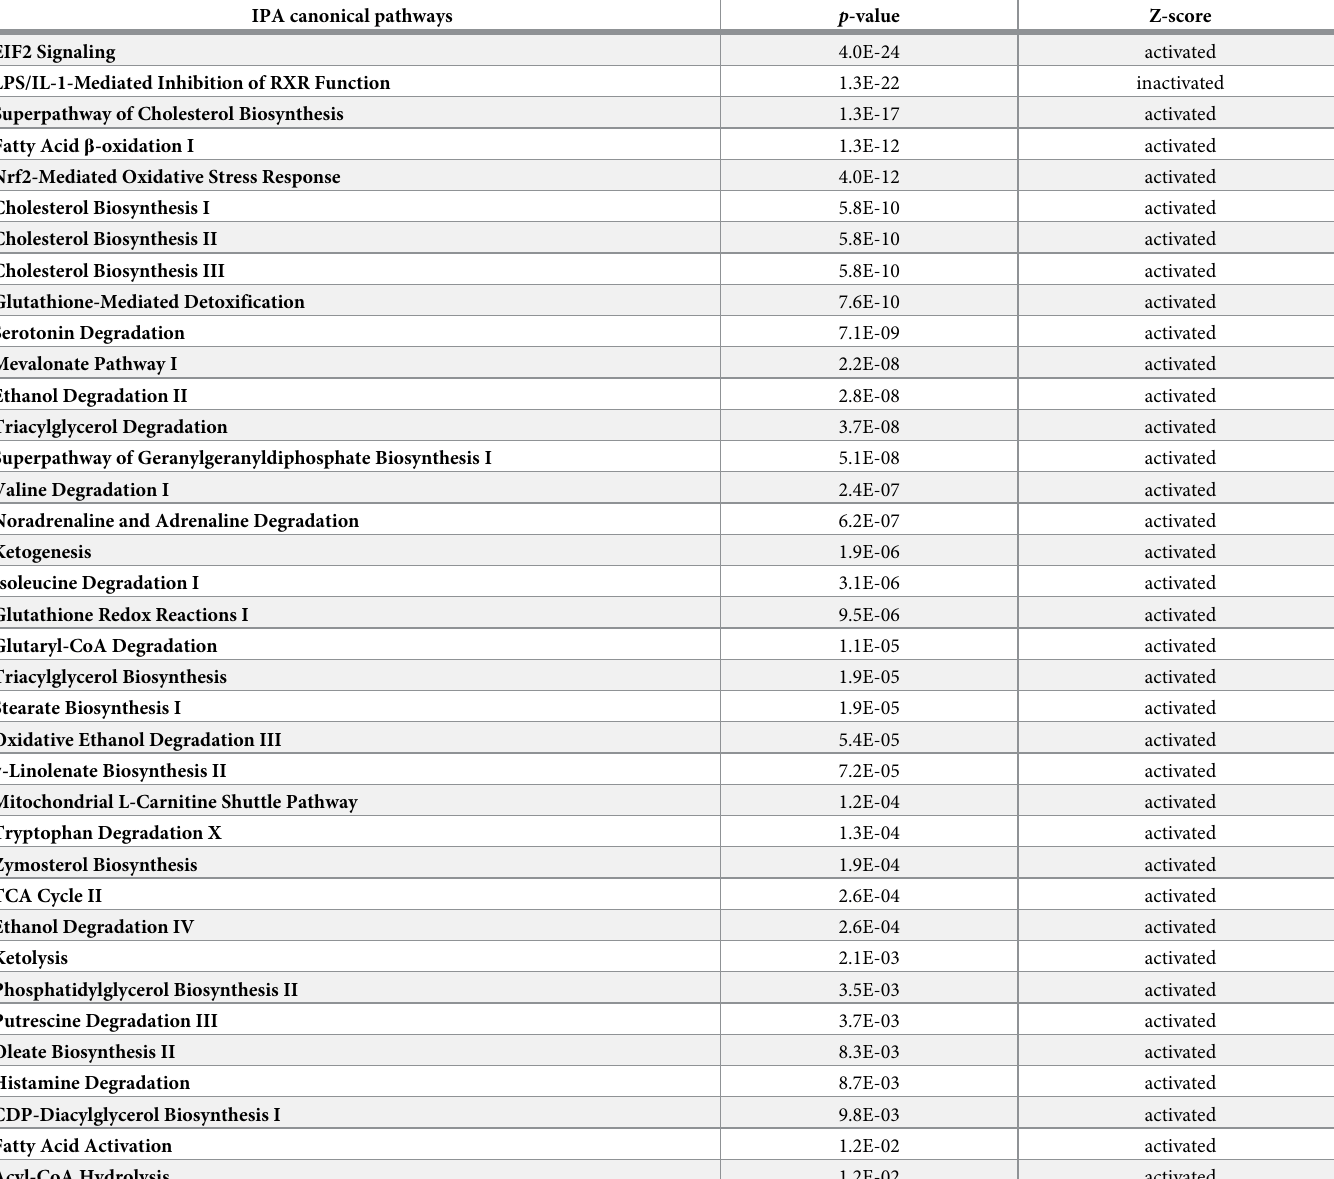
Table 2. Significantly activated/inactivated canonical pathways in the DEGs induced by iso- α -acids